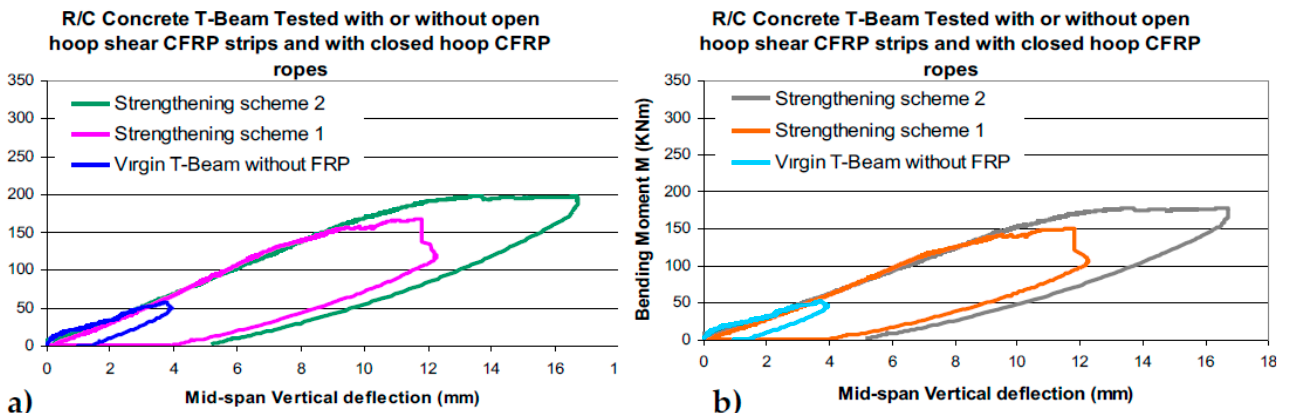
Figure 19. ( a ) The 2nd st rengthening scheme (East part). ( b ) Diagonal shear cracks at the East part of the prototype RC T-beam, which were checked by the applied CFRP anchor poles.